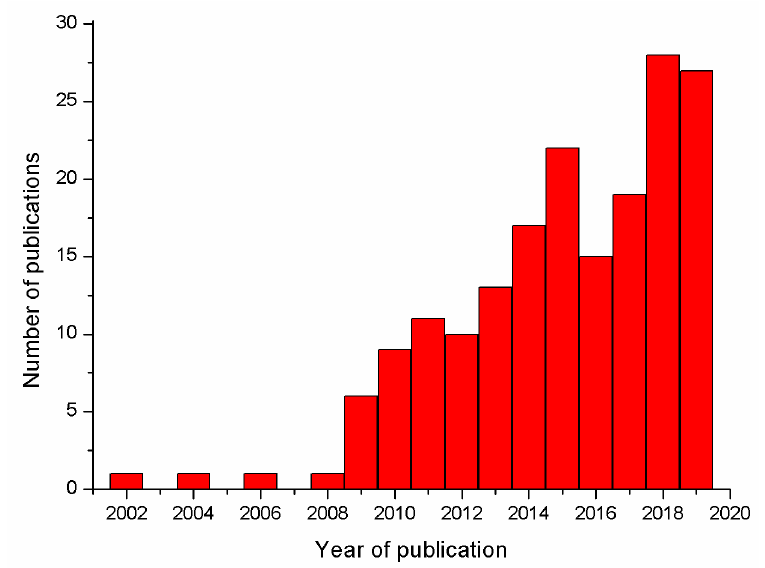
Figure 1. The annual number of publications (articles or conference papers) with the subject of